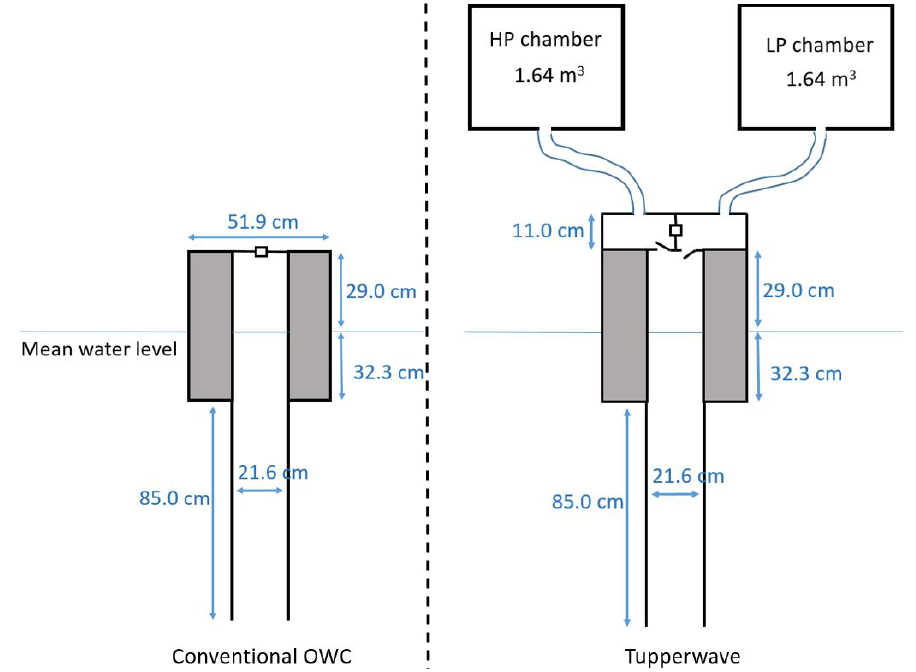
Figure 6. Schematic of the model scale conventional OWC and Tupperwave